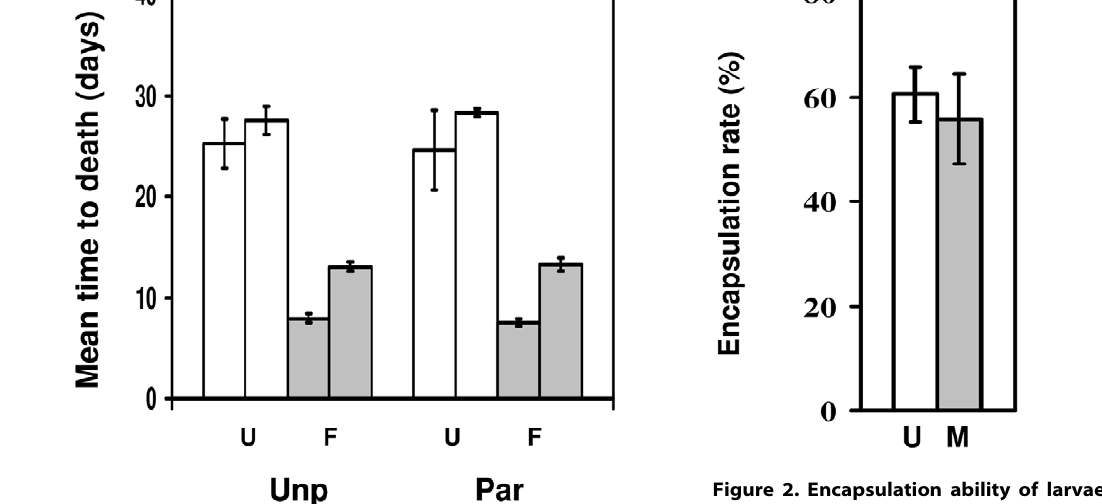
Figure 2. Encapsulation ability of larvae infected with micro- sporidia. Rate of encapsulation of Asobara tabida eggs by Drosophila melanogaster larvae which had either been infected with Tubulinosema kingi (M; grey bar) or had not been infected (U; white bar). Bars show mean 6 s.e.